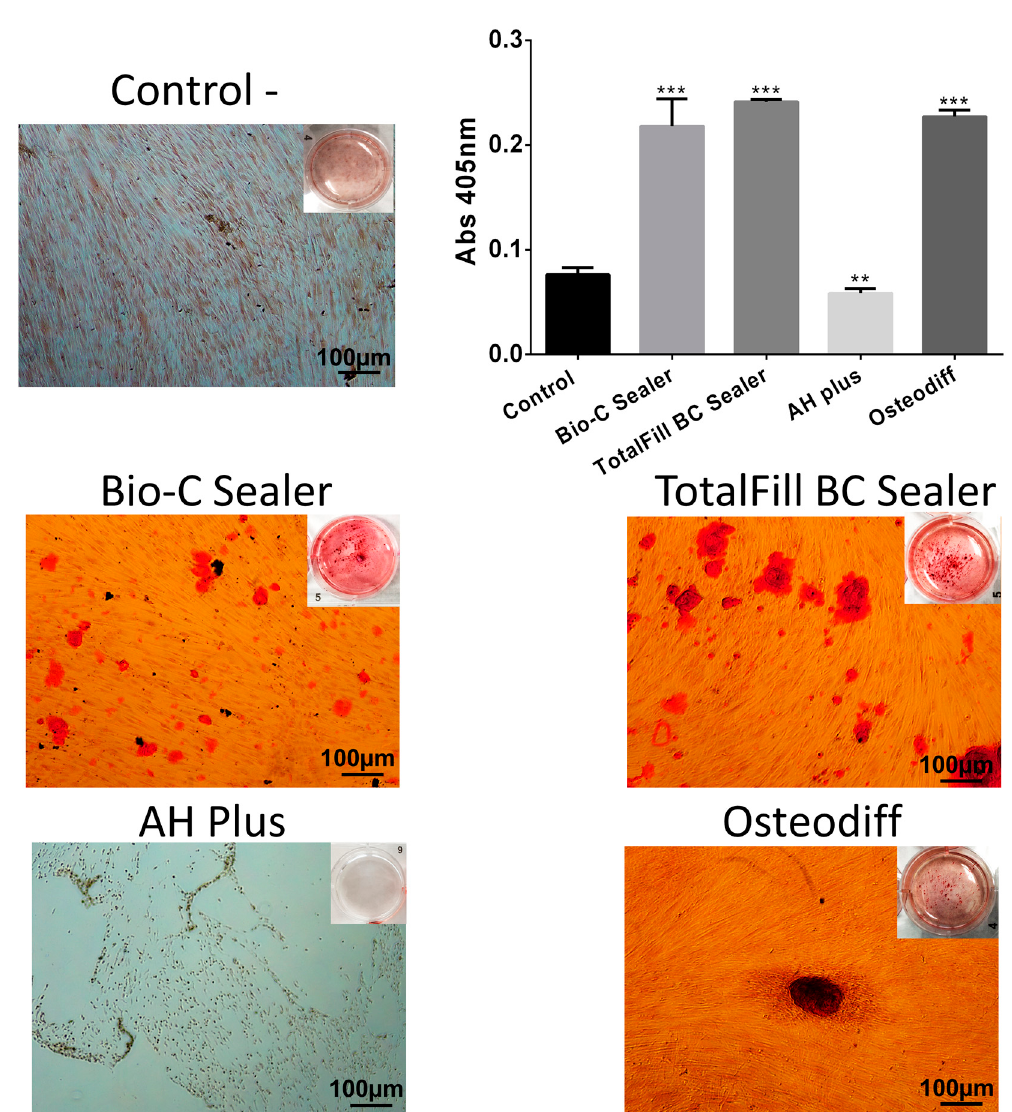
Figure 6. Induction of mineralization and Alizarin Red S staining. The effects of sealers on mineralization potential after 21 day of exposition. Data are presented as the mean ± standard deviation percentage of staining compared with the control (*p < 0.05; **p < 0.01; ***p < 0.001). Scale bar = 100 μ m.